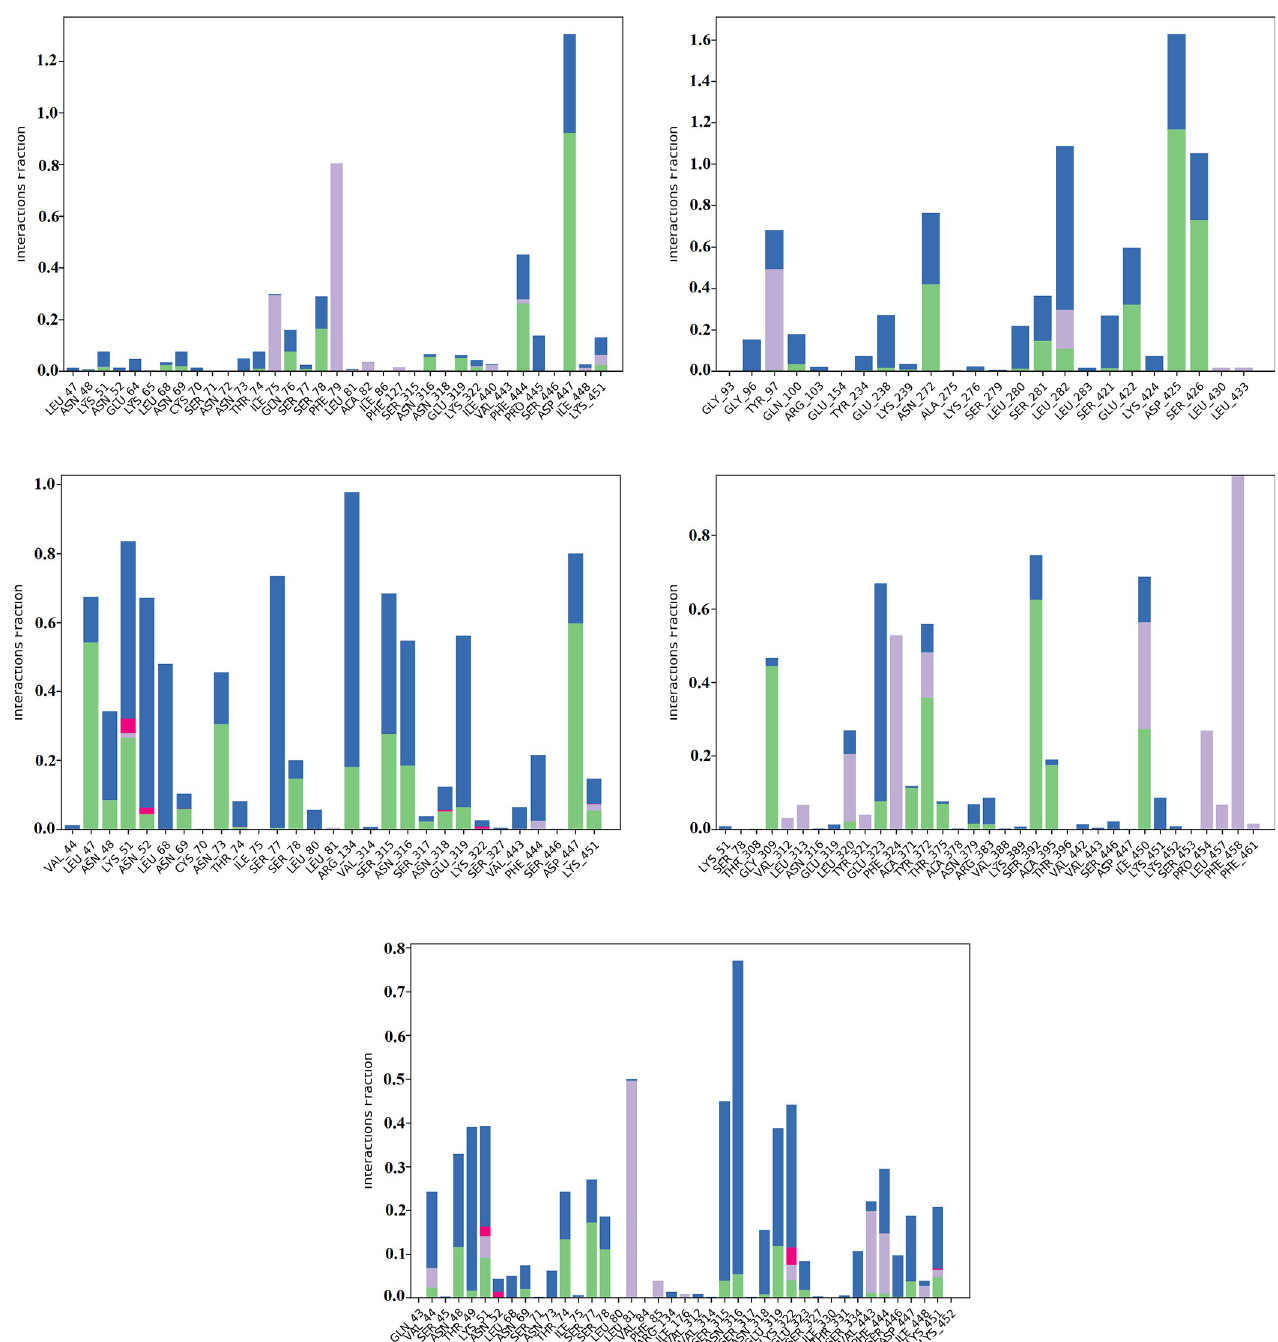
Fig 7. Percentage protein-ligands contacts monitored throughout 100 ns simulation run time of Pf HT1(6m20) complex with the lead compounds ( A : Avicularin CID5490064; B : Harpagoside CID5481542; C : Hyperoside CID5281643; D : Quercetagetin CID5281680; E : Sylibin CID5213) The stacked bar charts show the different types of interactions between the ligands and the Pf HT1 complex. The legend above depicts the type of interactions that occurred by means of the colour code. (CID5281643), a quercetin3-O-D-galactoside ( i . e ., quercetin with a beta-D-galactosyl residue attached at position 3), is a flavonol glycoside present in a variety of vegetables and fruits [47]. It is predominant in Hypericum mysorense [48]. Avicularin (CID5490064) or quercetin